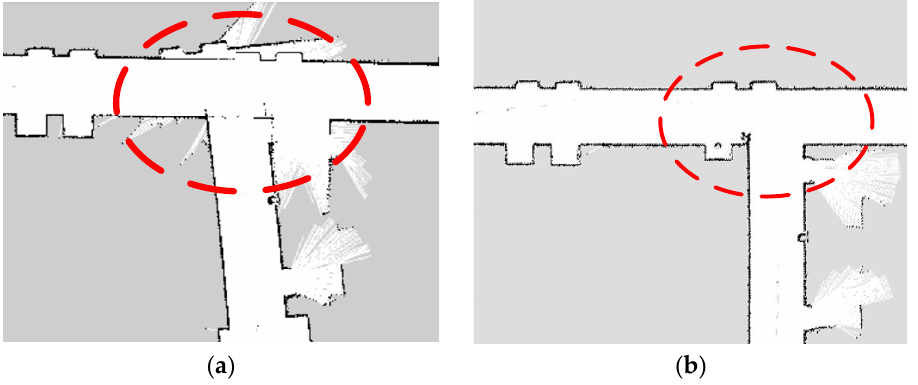
Figure 13. Ring corridor closed-loop connection for map construction before ( a ) and after ( b ) the calibration.